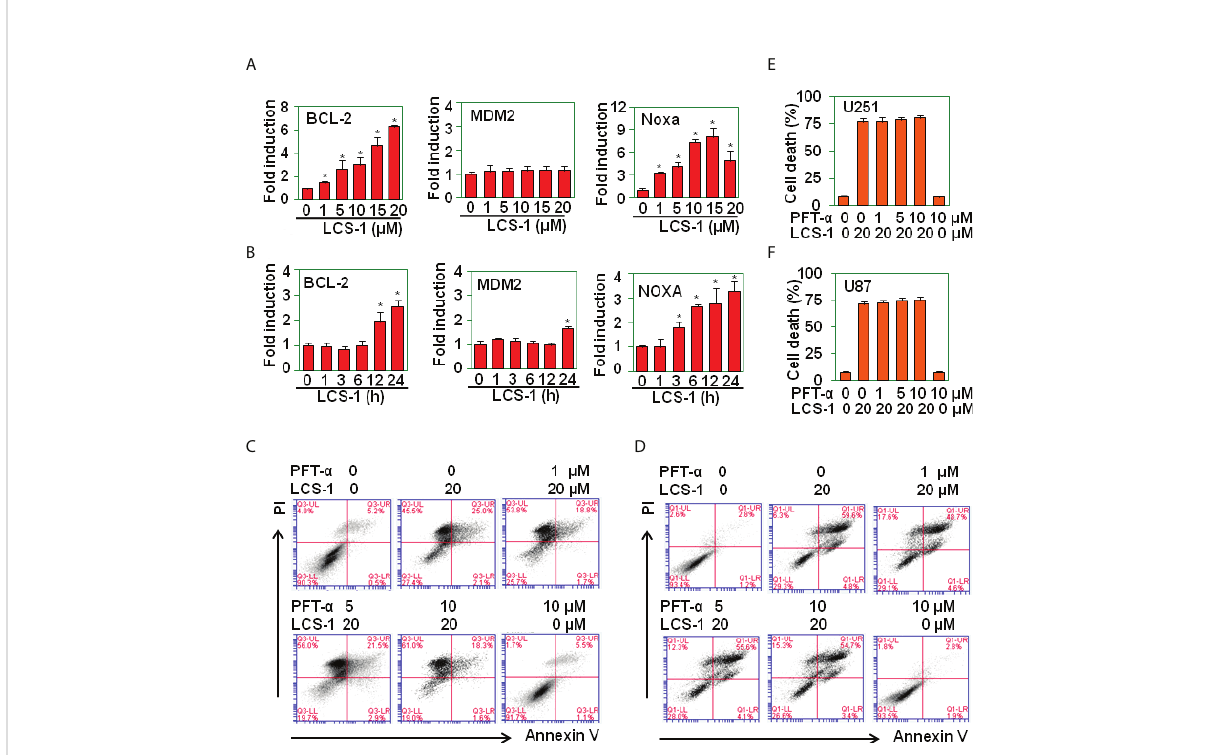
FIGURE 7 LCS-1-induced cell death is P53 in-dependent. (A) qRT-PCR analysis of the mRNA levels of P53-targeted genes in U251 cells treated with the indicated doses of LCS-1 for 12 h. * P < 0.05 compared with the medium groups. (B) qRT-PCR analysis of the mRNA levels of P53-targeted genes in U87 cells treated with 10 m M LCS-1 for the indicated time periods. * P < 0.05 compared with the medium groups. (C, D) PI/FITC- Annexin V staining of death of U251 (C) and U87 (D) cells pretreated with the indicated doses of P53 inhibitor Pi fi thrin- a (PFT- a ) for 1 h and retreated with 20 m M LCS-1 for 24 h. (E, F) Quantitative data from C (E) and D (F) . * P < 0.05 compared with LCS-1-treated alone